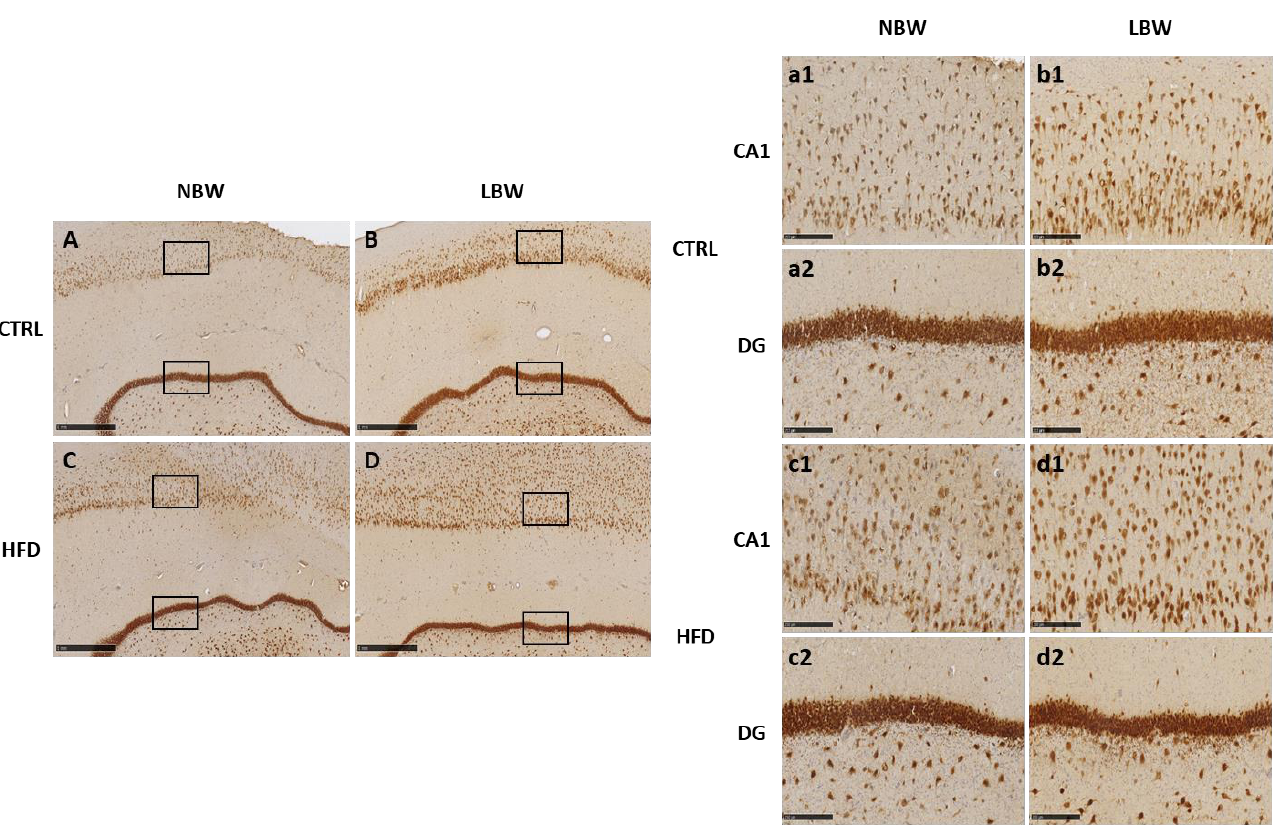
Figure 1. NeuN immunostaining on the hippocampus of one year-old pigs born with normal birth weight (NBW) or low birth weight as result of IUGR (LBW) and fed a control diet (Ctrl, A - B ) or an HFD diet ( C - D ). Representative images show the mature neurons immunostained with the NeuN antibody. Panels are magnifications of the CA1 ( a1 – d1 ) and DG ( a2 – d2 ) areas shown using black boxes. Scale bars: 1000 µm ( A – D ), and 250 µm ( a1 – d1 , a2 – d2 ).